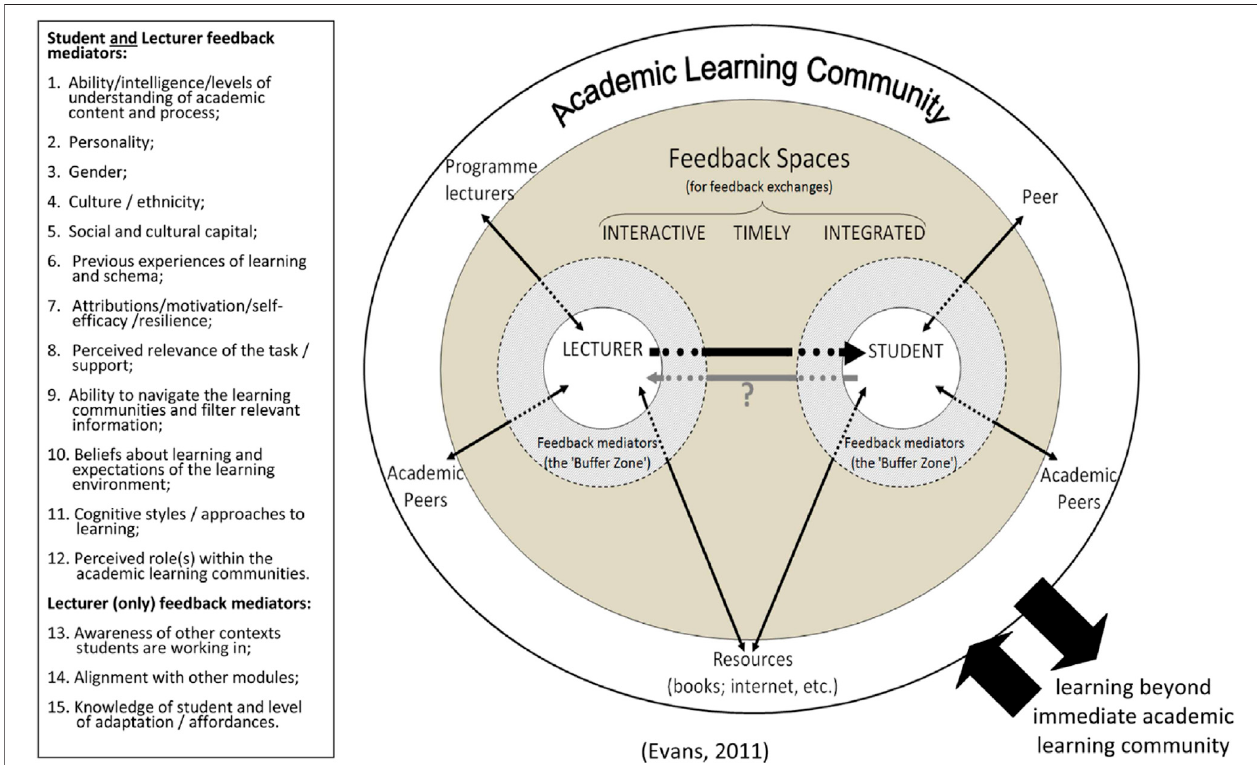
FIGURE 13 | Evans (2013) Feedback landscape